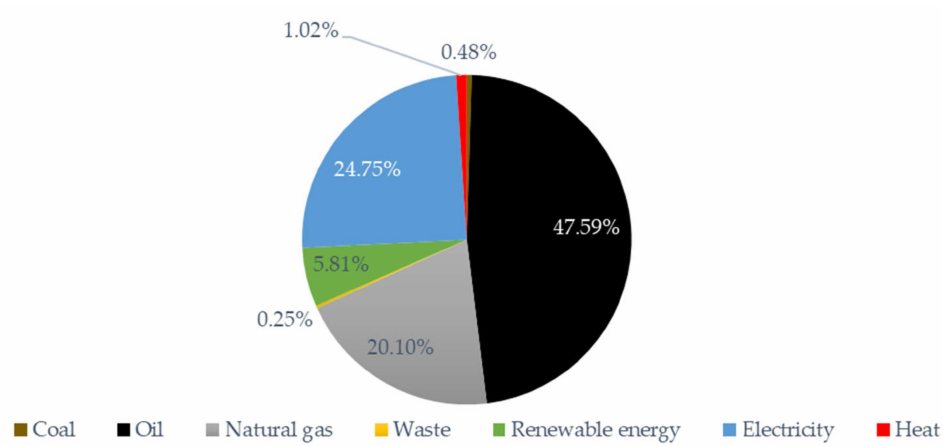
Figure 2. Energy sources in final consumption in reference